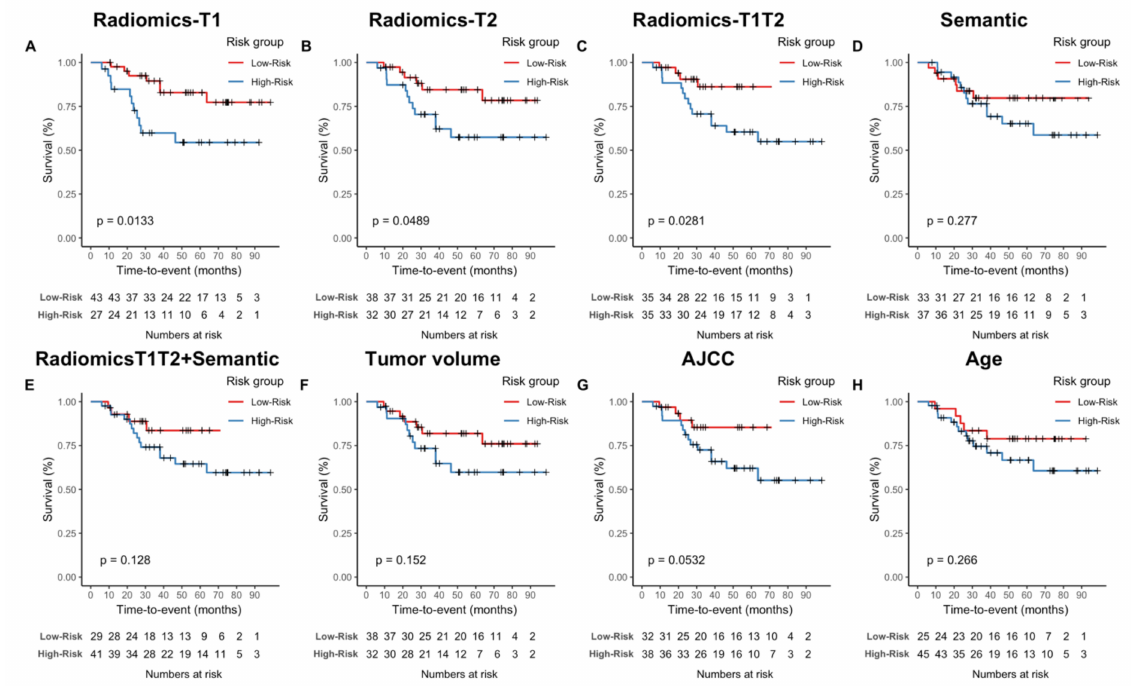
Figure 3. Kaplan–Meier survival analyses of developed models in the testing cohort. ( A – F ) Kaplan–Meier survival curves. Cohorts were split based on the median predictor value determined on the training cohort. ( G , H ) As a consequence, the AJCC staging system was split between stage III and stages IIA/B.